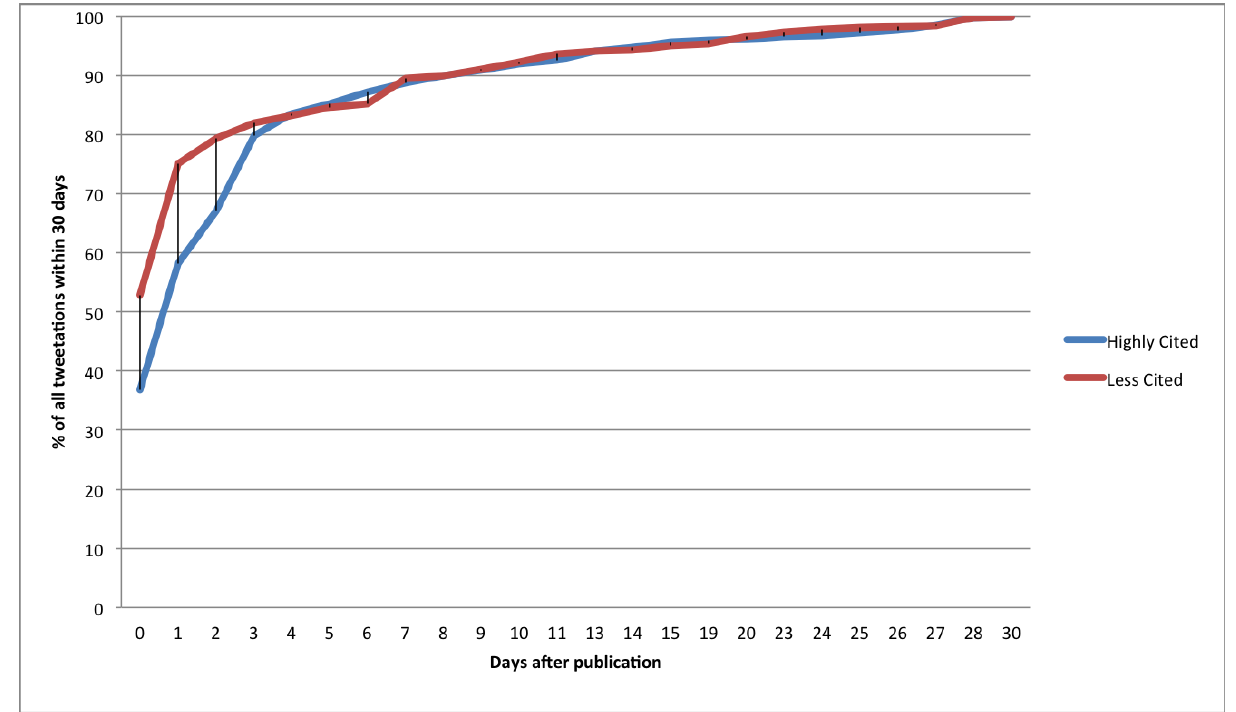
Figure 11. Tweetation curves: cumulative tweetations (tw n ), as a proportion of all tweetations sent within 30